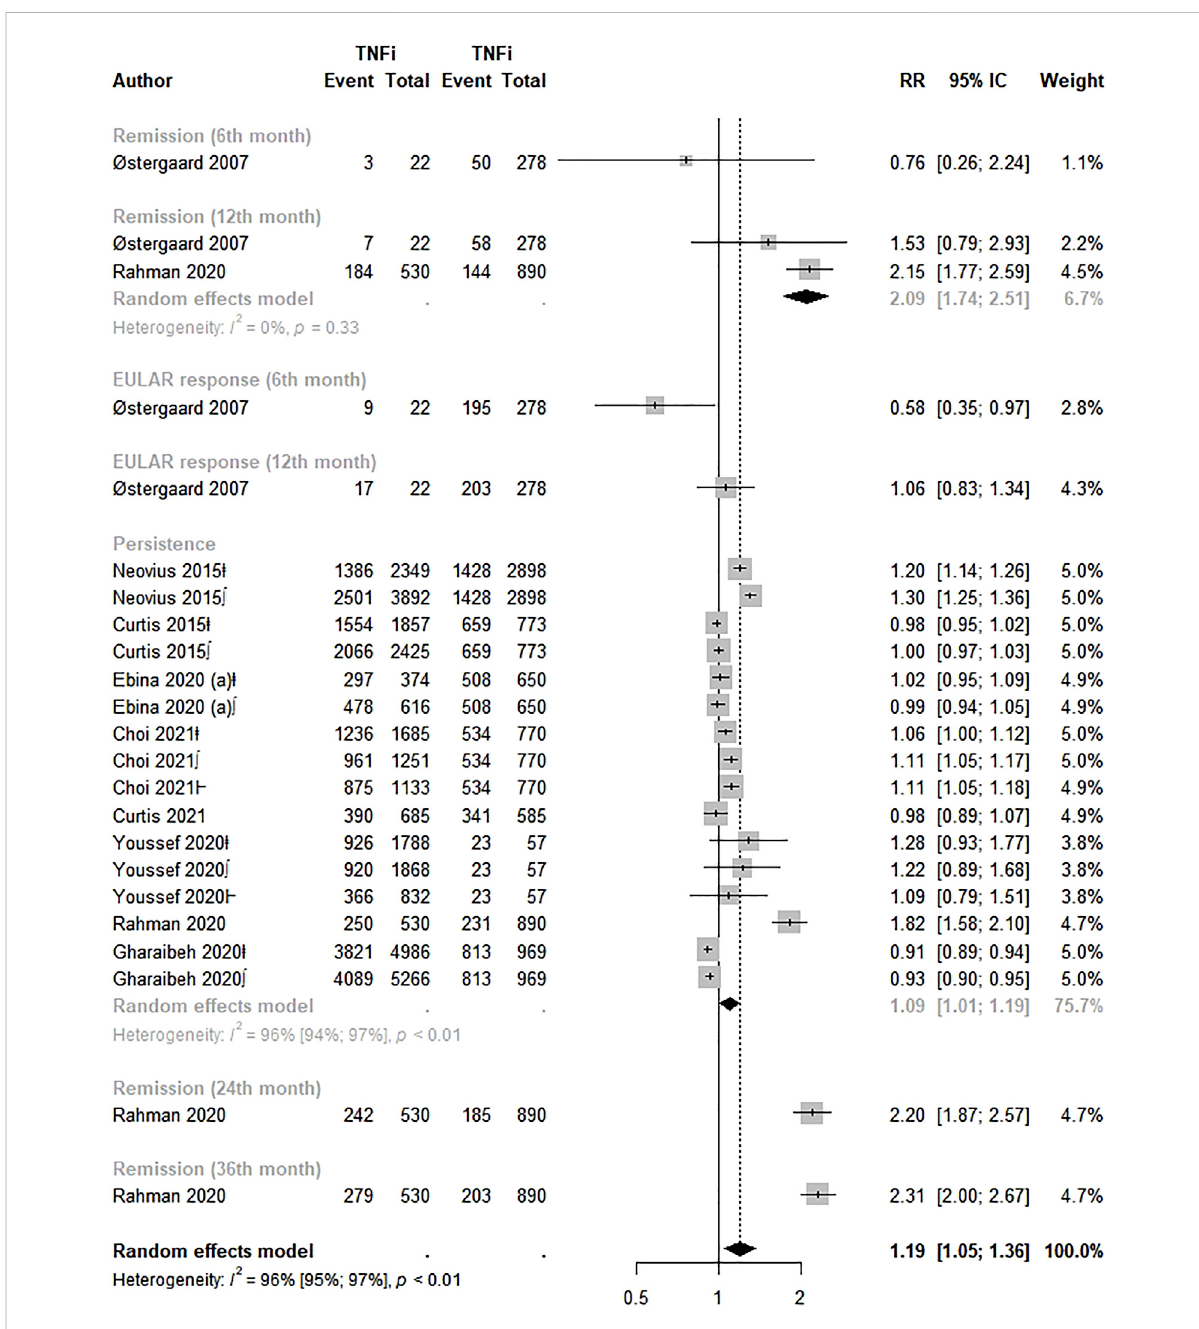
FIGURE 3 Effectiveness of Adalimumab, Etanercept and Golimumab compared to In fl iximab. TNFi, TNF inhibitors; ⱡ , adalimumab; (cid:1) , etanercept; Ⱶ ,